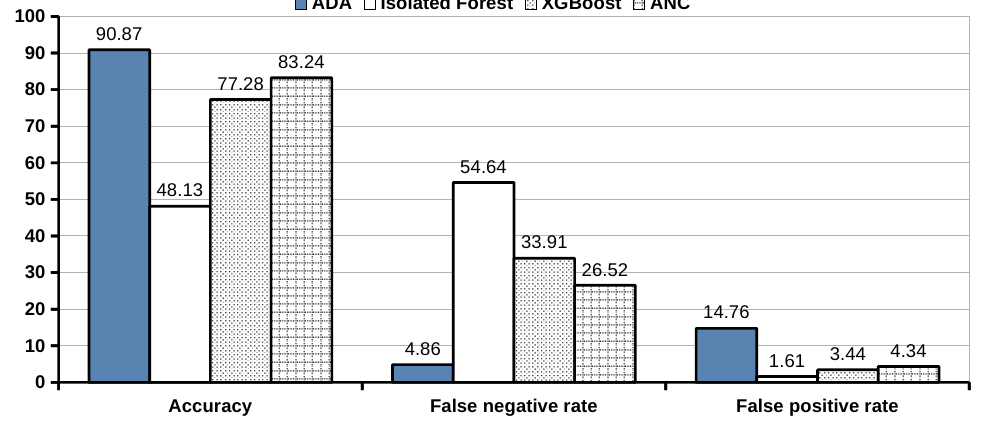
Figure 13. Comparison of anomaly detection between ADA and other techniques in NSL-KDD dataset.